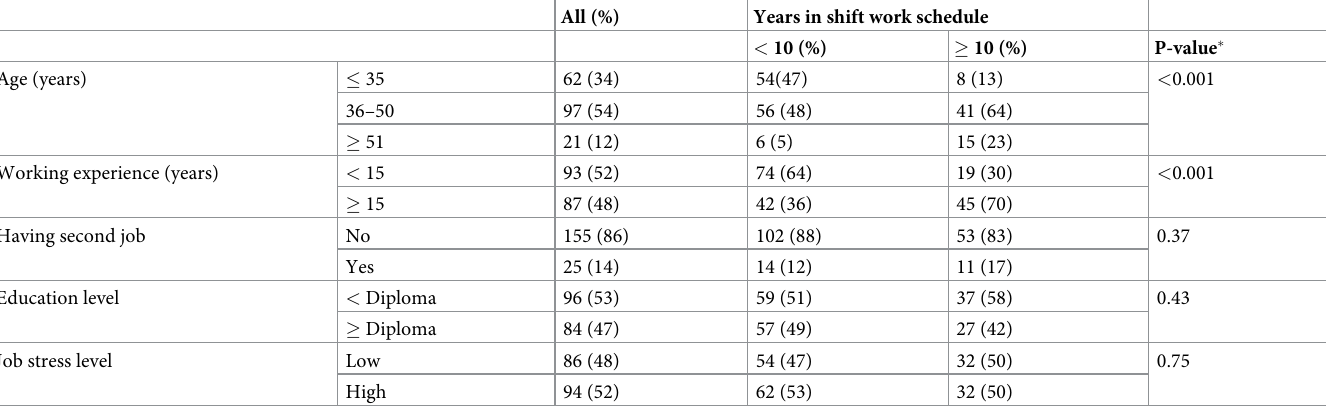
Table 1. Distribution (%) of the workers (n = 180), based on their background and working factors.